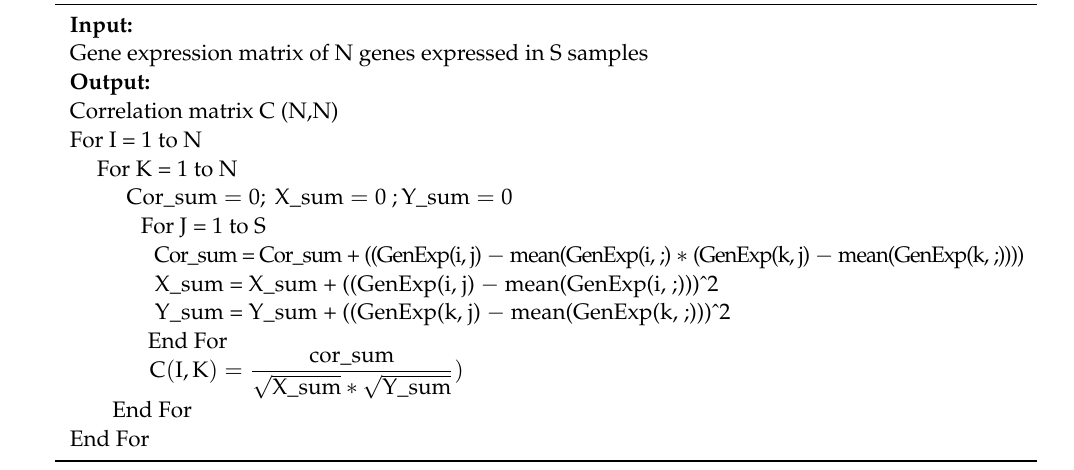
Algorithm 1: A serial algorithm for computing the Pcc in gene co-expression